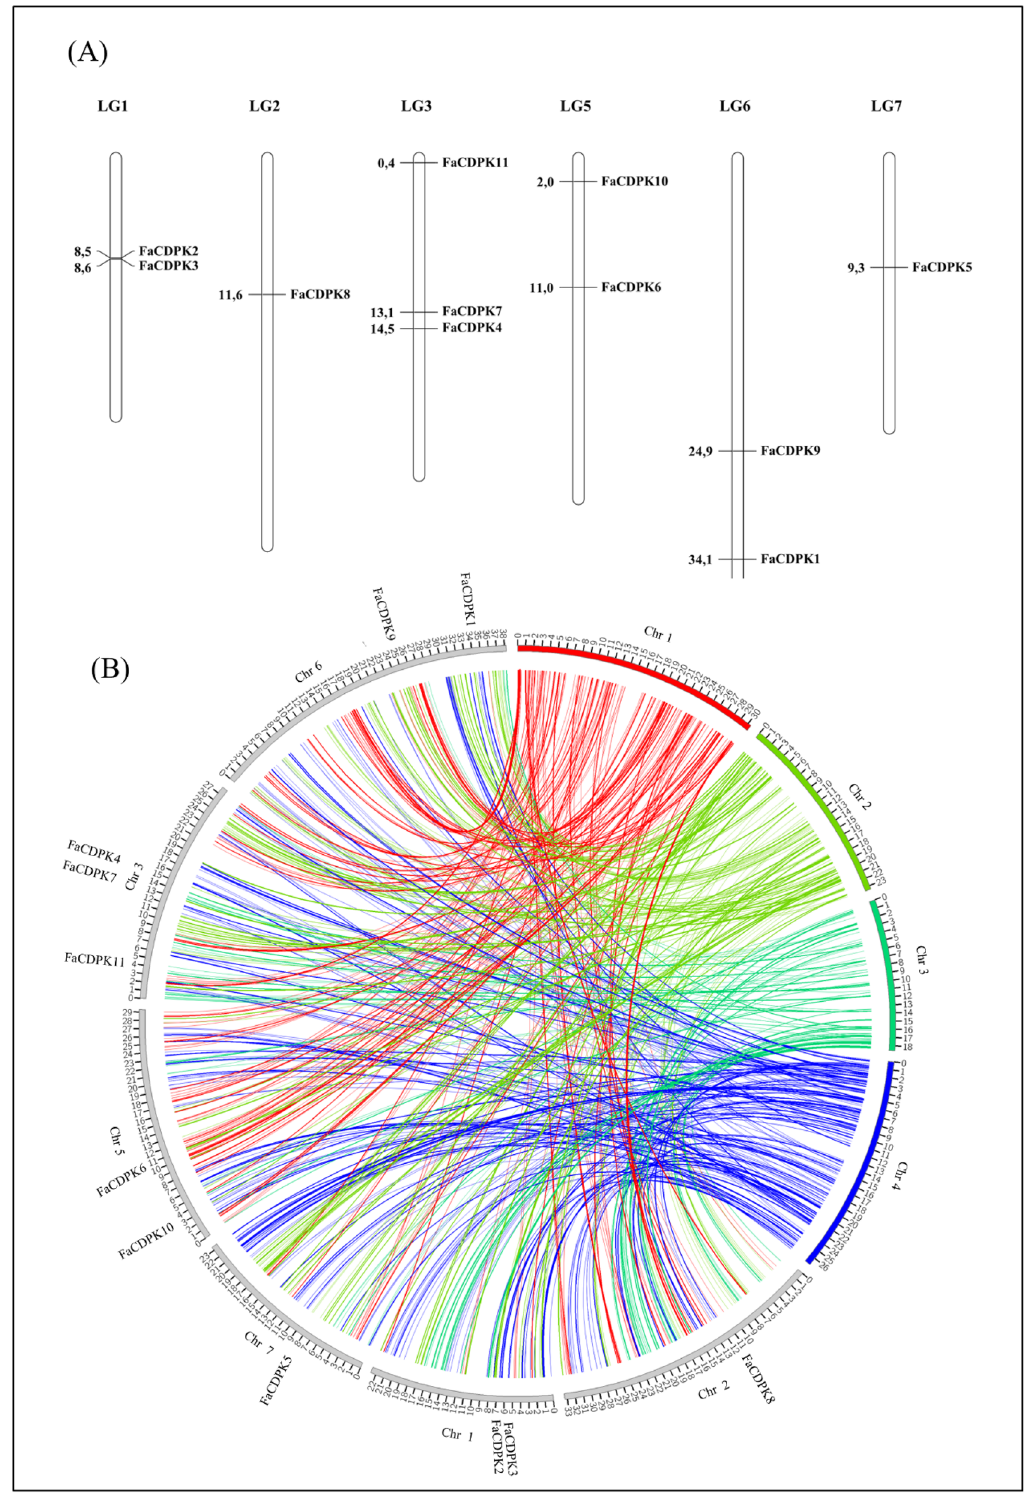
Figure 3. ( A ) Chromosomal distribution of the FaCDPK genes in the chromosomes of F. vesca . Chromosome numbers are provided at the top of each chromosome. ( B ) Synteny analysis of CDPK genes between strawberry ( Fragaria x ananassa ) and Arabidopsis thaliana